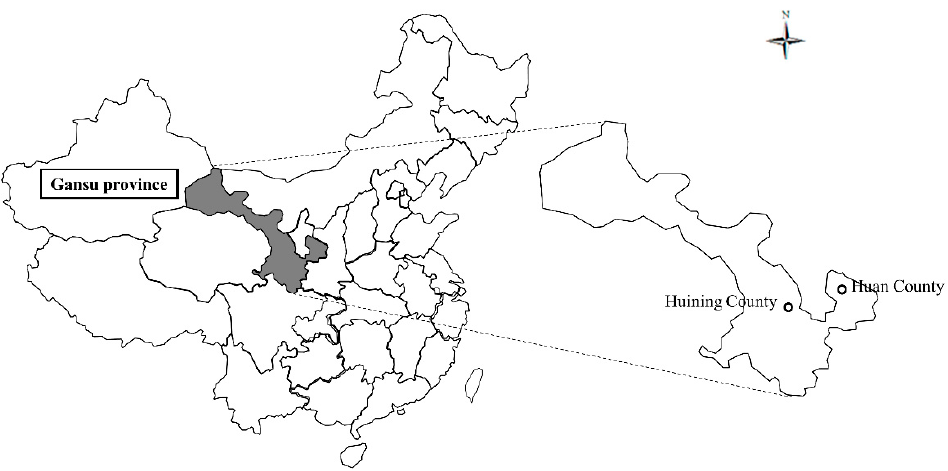
Figure 1. The geolocation of Huining County and Huan County in Gansu Province, China .